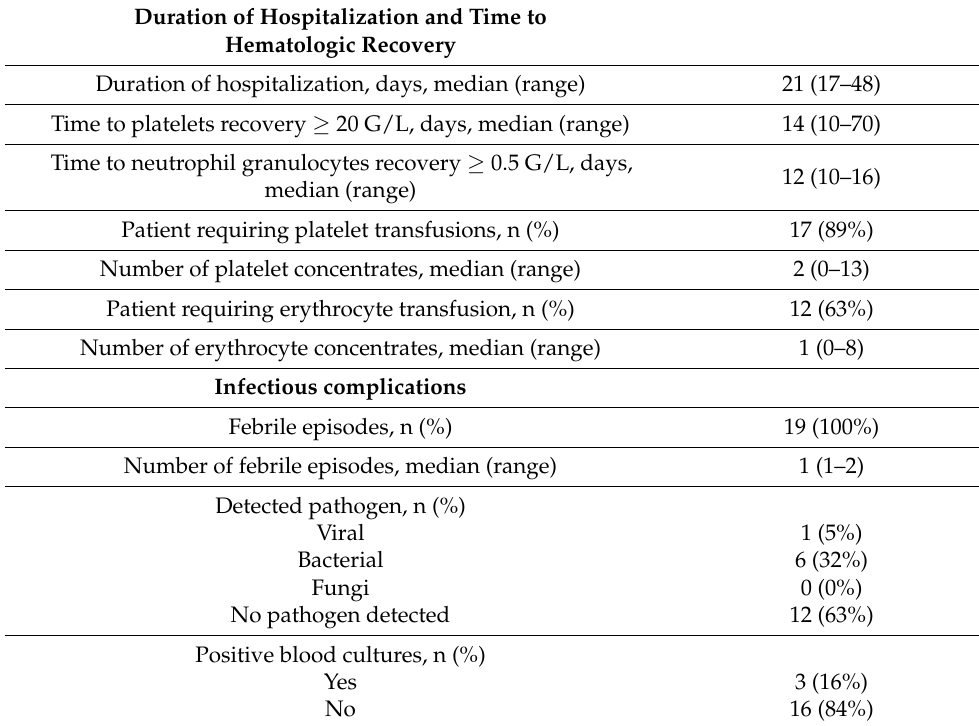
Table 4. Hematologic recovery after HDCT a and ASCT b in the study cohort. Duration of Hospitalization and Time to